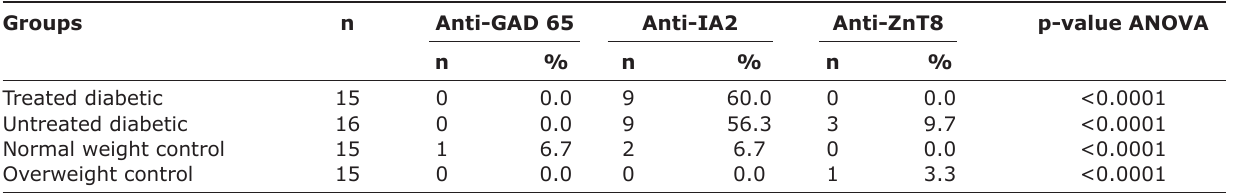
Table showing the distribution of the presence of antibodies in the treated and untreated diabetic groups; and normoglycemic normopese and obese. Differences in the presence of antibodies between groups analyzed by